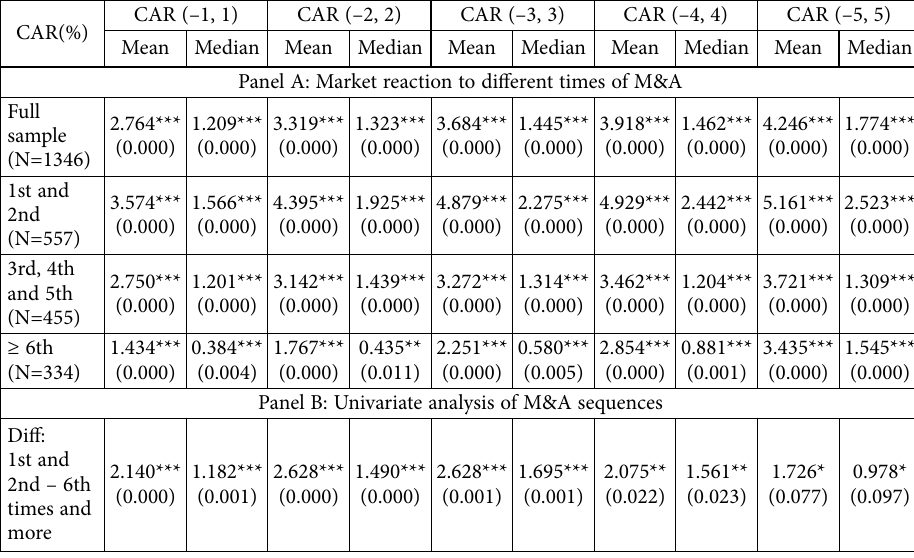
Table 15. Market reaction to M&A